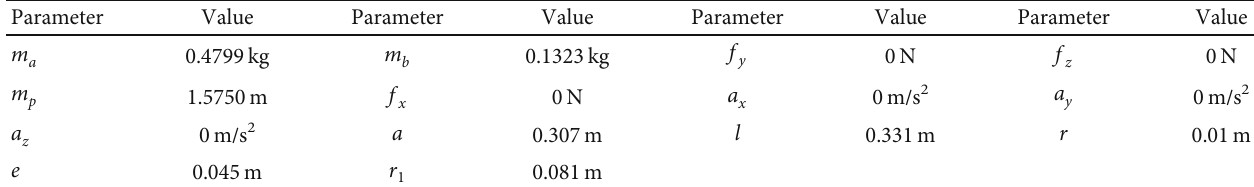
Table 3: The structural and dynamic